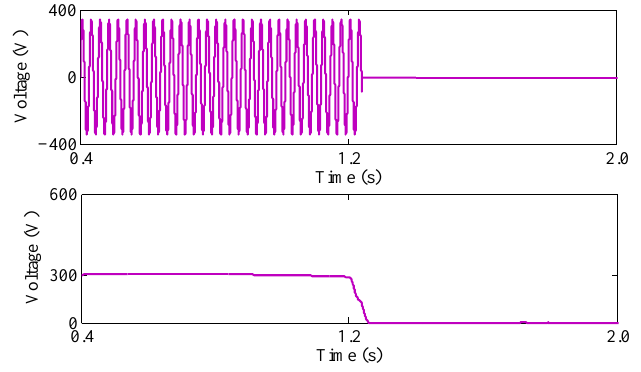
Figure 16. Grid voltage ( top ) and output voltage of the bidirectional converter in rectification mode ( bottom ) under the transition from Mode II to Mode